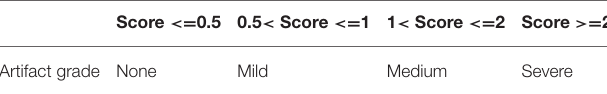
TABLE 1 | Thresholding system for determining artifact